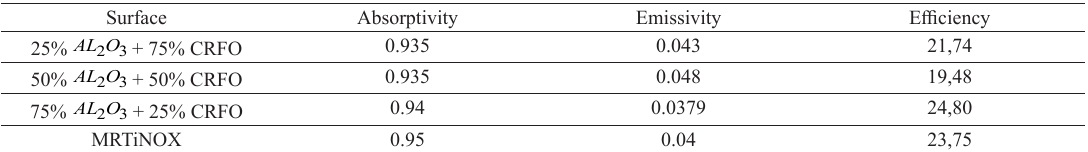
Table 5. Absorptivity and emissivity of selective surfaces.